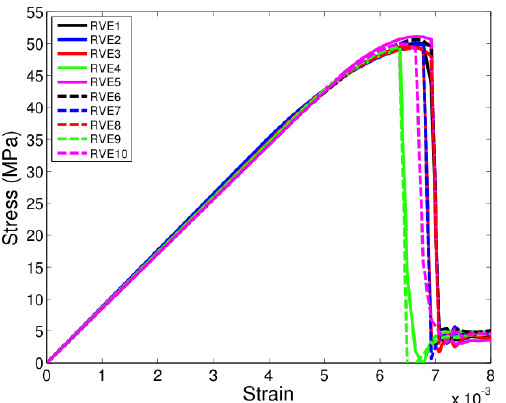
Figure 8. Transverse tensile response of six-fiber unit cells with V